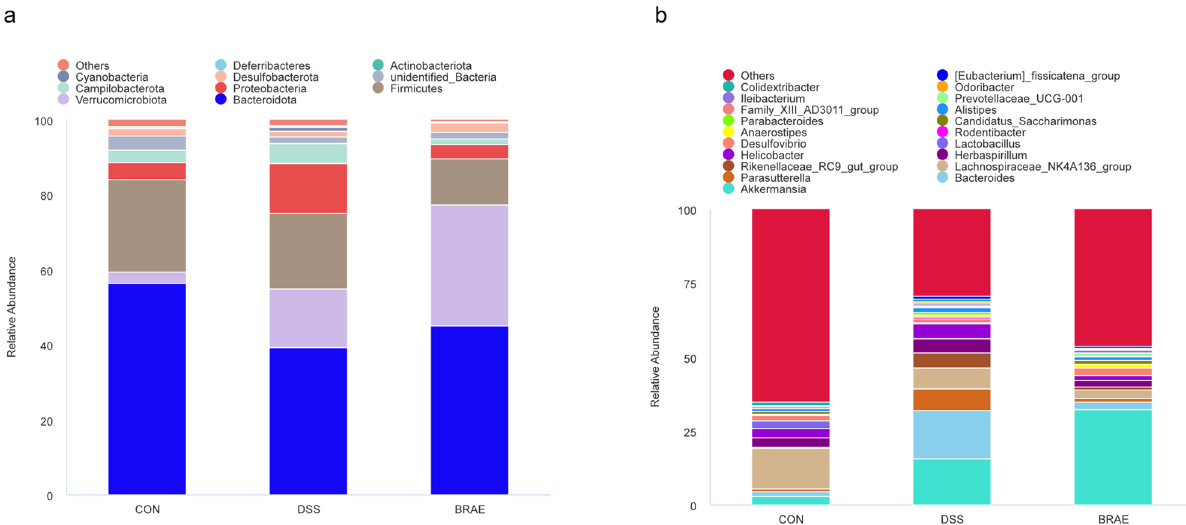
Figure 10: Distribution map of species in each group. ( a ) Relative abundance of gut microbiota at the phylum level; ( b ) relative abundance of gut microbiota at the genus